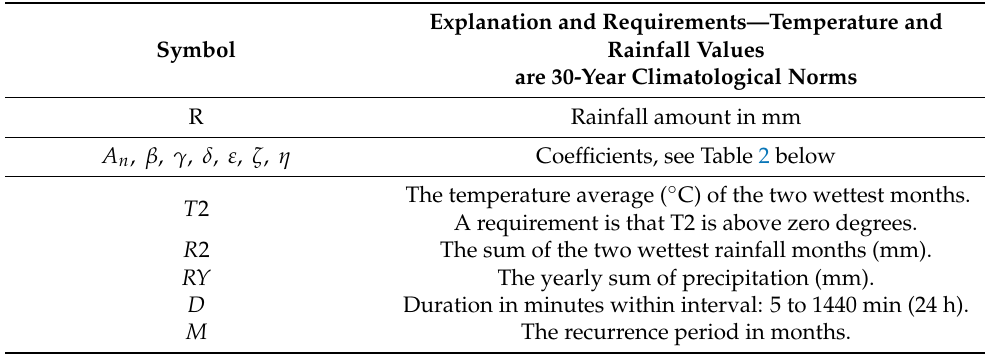
Table 1. Explanation of symbols.